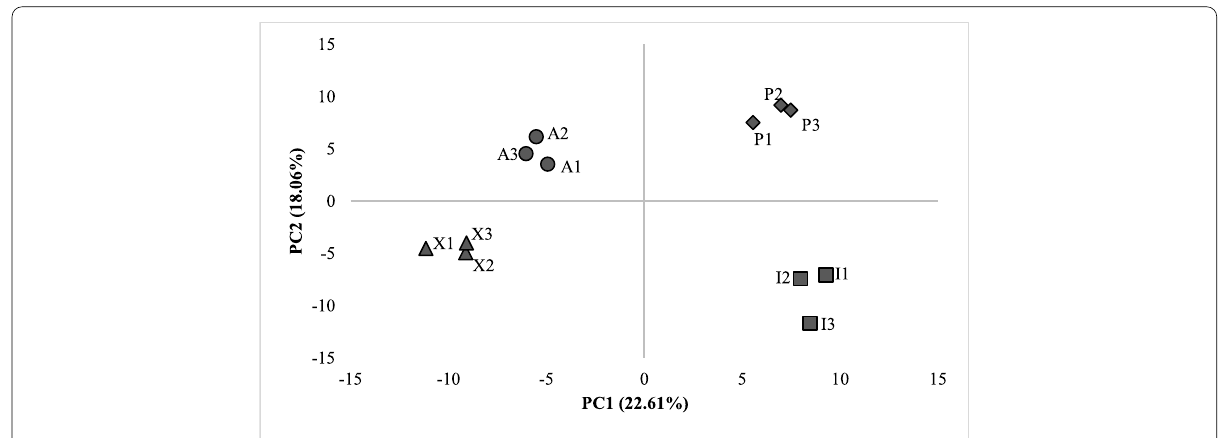
Fig. 5 PCA plots of 297 matched spots volume (%Vol) of 12 2-DE gels from grains of four Brazilian cowpea ( Vigna unguiculata ) cultivars. (A) BRS Aracê, (I) BRS Itaim, (P) BRS Pajeú, and (X) BRS Xiquexique. Numbers 1, 2, and 3 refer to the triplicate of each cultivar gels. Proteins were separated by 2-DE SDS-PAGE using 13 cm pH 4–7 IPG